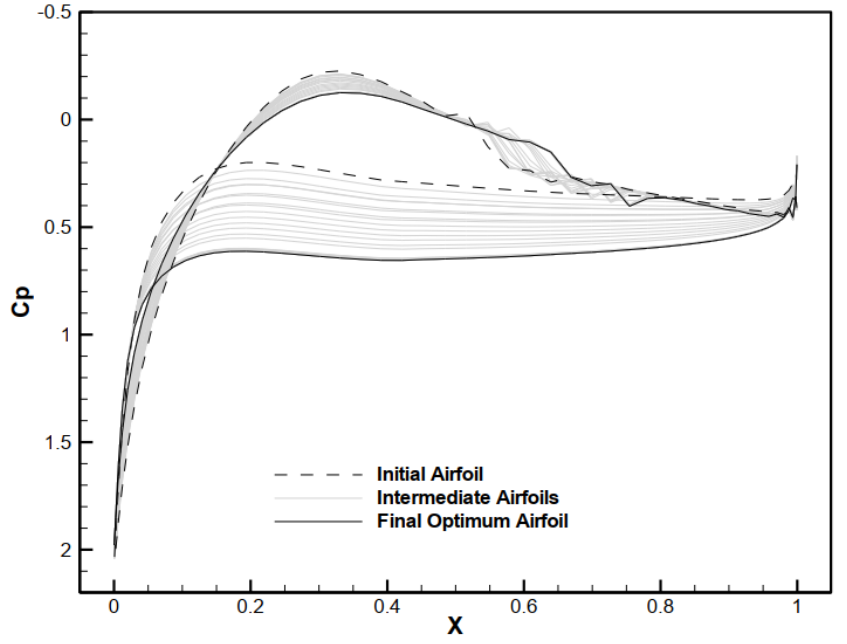
Figure 7. The proposed multipurpose optimization algorithm generated modifications in the pressure coefficient C p around the airfoil.